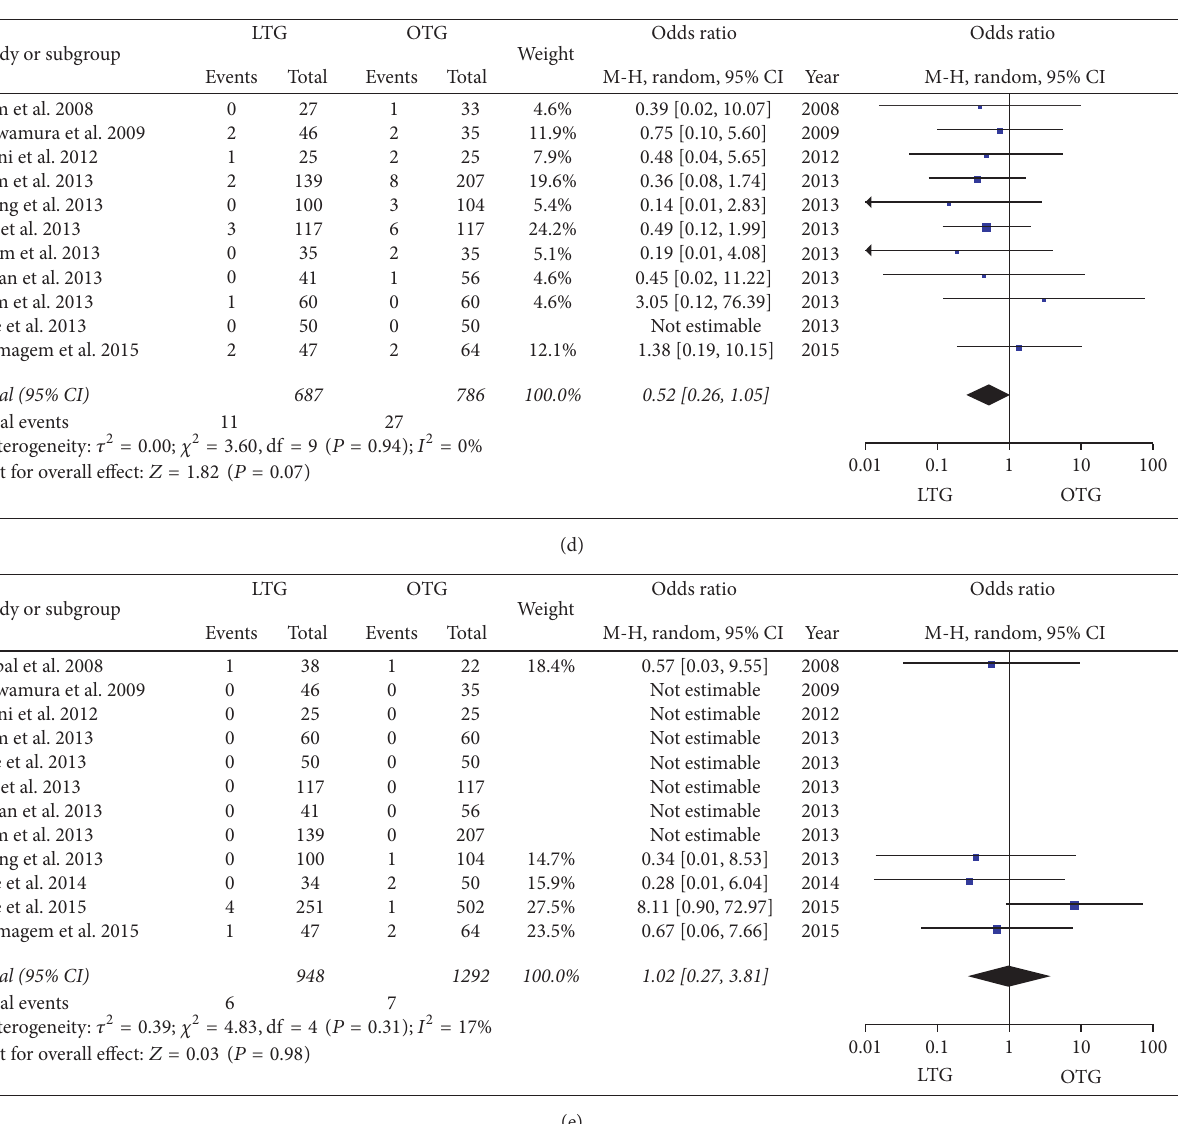
Figure 2: (a) Comparison of anastomotic complications between LTG and OTG. (b) Comparison of other intra-abdominal complications between LTG and OTG. (c) Comparison of wound complications between LTG and OTG. (d) Comparison of pulmonary complications between LTG and OTG. (e) Comparison of mortality between LTG and